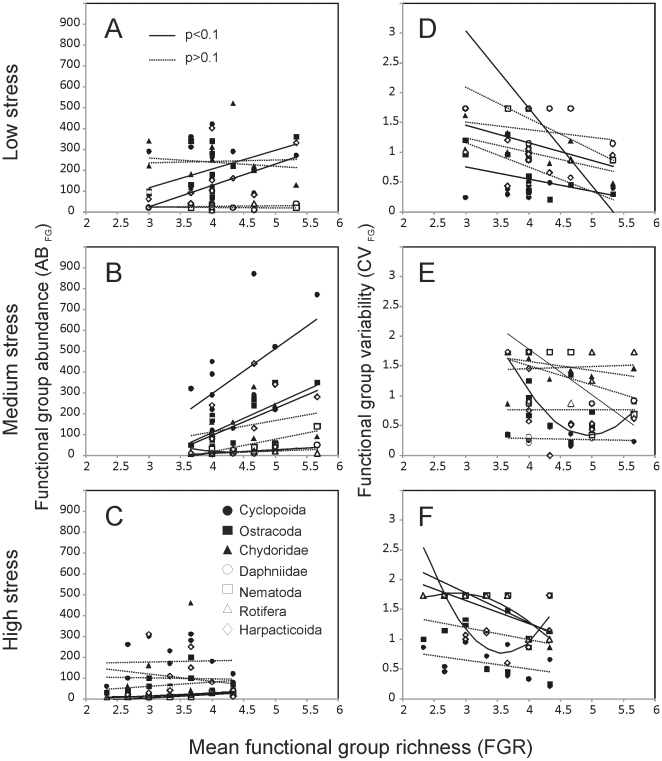
Response diversity of functional groups.Response diversity for low stress (A, D), medium stress (B, E), and high stress (C, F) treatments for mean functional group richness (FGR) and total abundance within functional groups (ABFG; A–C) and functional group variability (CVFG; D–F).